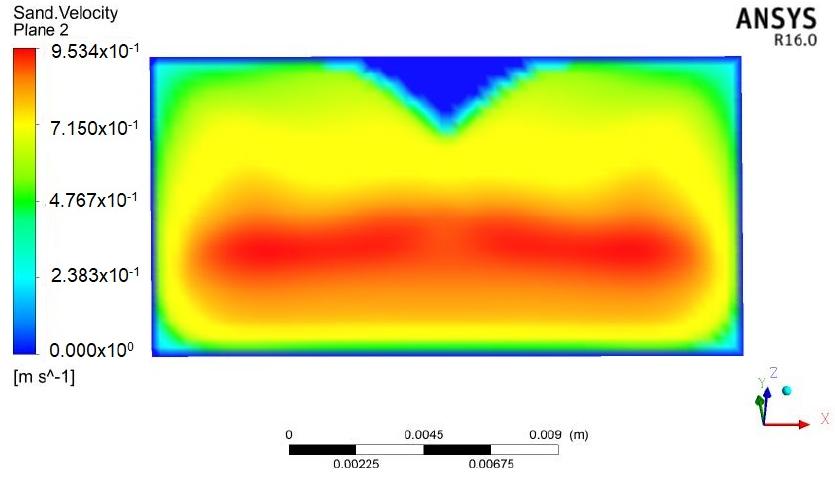
Figure 5. Sand velocity at plane 2.